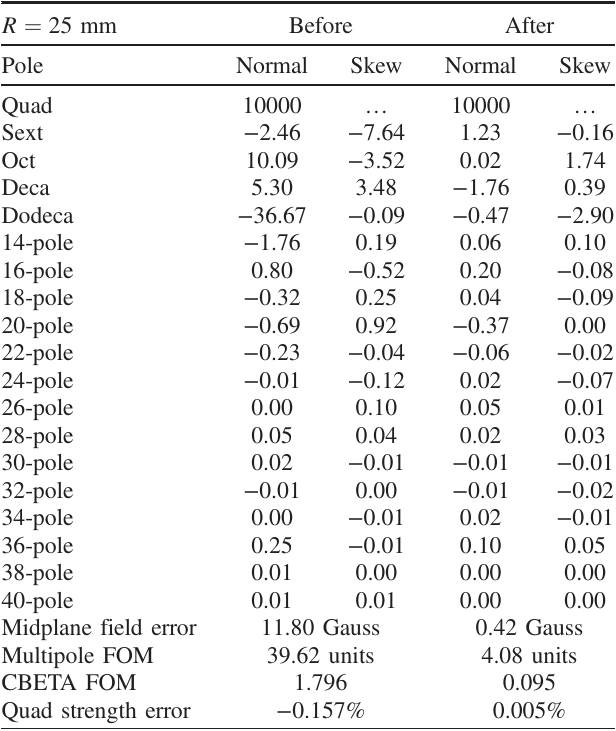
TABLE III. Multipole harmonics during correction of QD Magnet 2412. R ¼ 25 mm Before After Pole Normal Skew Normal Skew Quad 10000